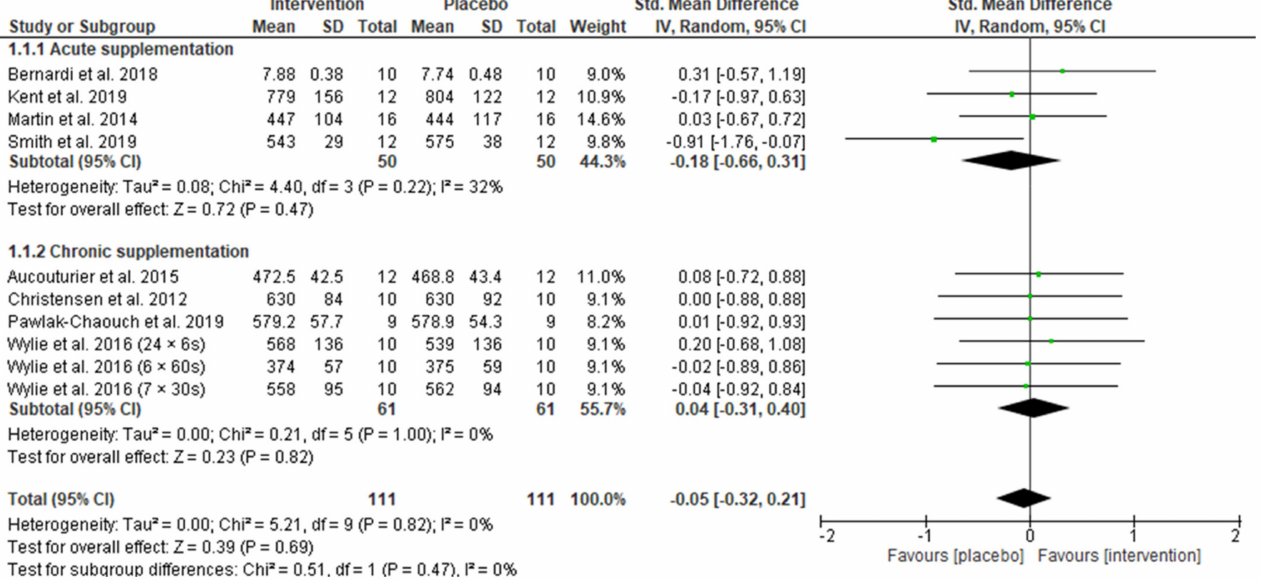
Figure 3. Forest plot comparing the effect of acute and chronic beetroot supplementation on mean power